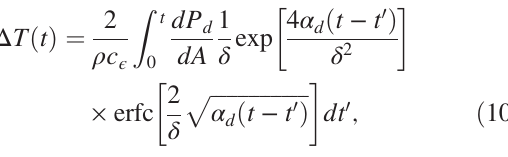
FIG. 13. Peak E-field (a) and H-field (b) of the trapped mode at 55 GHz, excited by a 10-nC bunch.